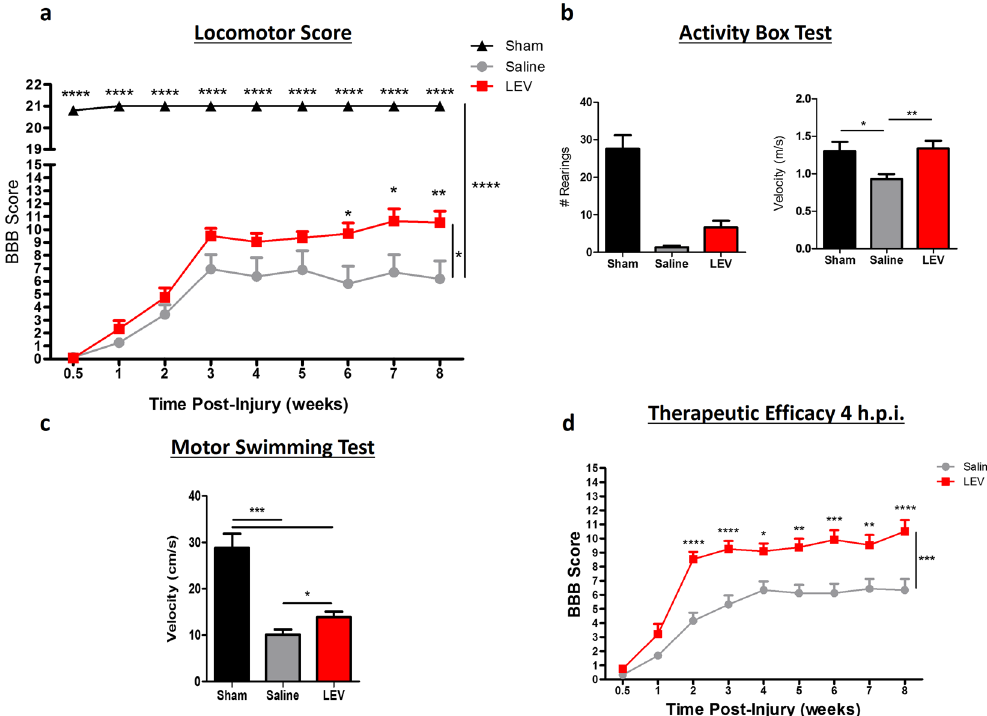
Fig. 1 LEV treatment promotes signi fi cant functional locomotor recovery after thoracic SCI. a LEV-treated animals 8 weeks post injury were able to perform occasional weight-supported plantar steps, while saline-treated animals were only able to perform extensive movement of two joints and a slight movement of the third. Moreover, from 6th to 8th week post injury, the locomotor functions of LEV-treated rats were signi fi cantly higher than the saline-treated animals. b LEV-treated rats presented higher number of rearing and signi fi cantly higher velocity during locomotion. c Motor swimming test demonstrated that LEV treatment leads to signi fi cant better locomotor performance when compared to saline-treated animals. Sham n = 3; Saline n = 8; LEV n = 14. d LEV treatment 4 hpi is also able to promote signi fi cant functional locomotor recovery after SCI. From the 2nd to the 8th week post injury, the locomotor functions of LEV-treated rats were signi fi cantly higher than the saline-treated animals. Saline n = 15; LEV 4 hpi n = 15. Values shown as mean ± SEM. * p < 0.05; ** p < 0.01; *** p < 0.001; **** p <